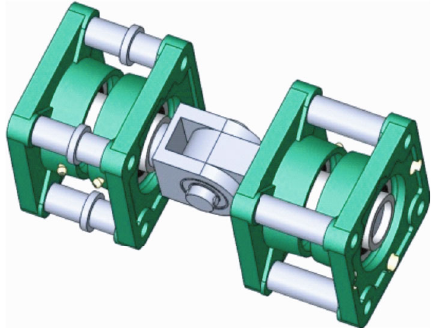
Figure 19: Equivalent ball pair.